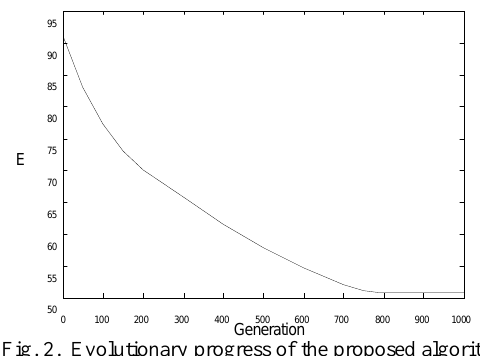
Fig. 2. Evolutionary progress of the proposed algorithm The simulation results denote that the reconciled value of each amount is no longer change positively Table 4. Data reconciliation results with the proposed after 786 generations. According to the criteria of data algorithm reconciliation, reconciled value of every variable satisfies balance equations, the objective function decreased and stabilized after 786 generations (4.3 seconds), reconciliation goal is achieved. Besides, from the results, it is possible to use a great number of generations to obtain good results.